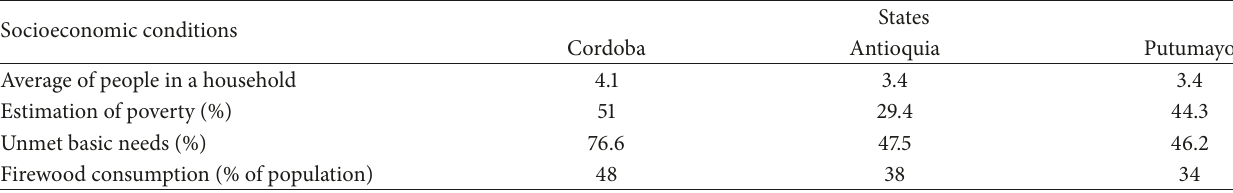
Table 2: Socioeconomic conditions of Cordoba, Antioquia, and Putumayo states in rural zones: people in a household, poverty, and percentage of firewood consumption.